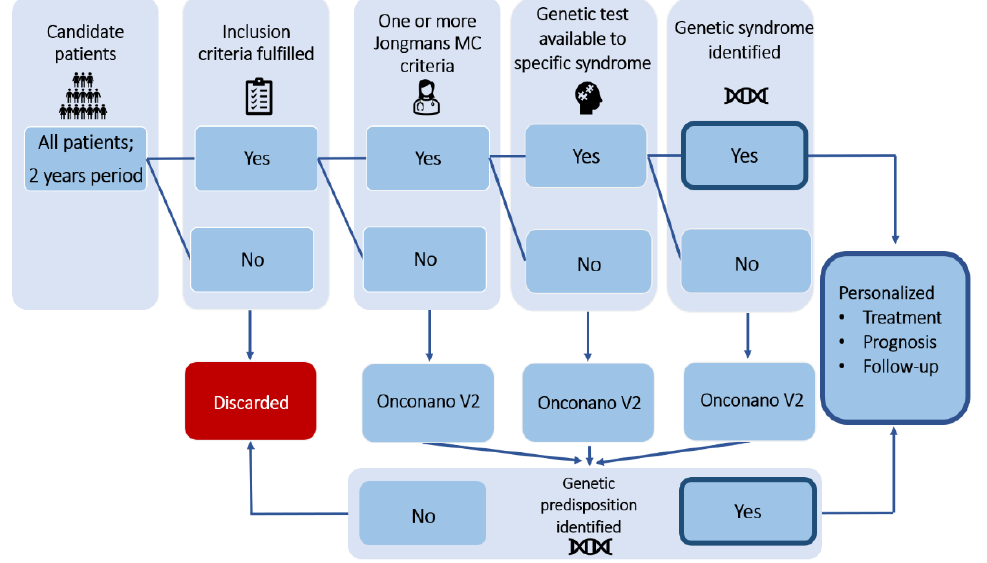
Figure 1. Workflow established for the study.